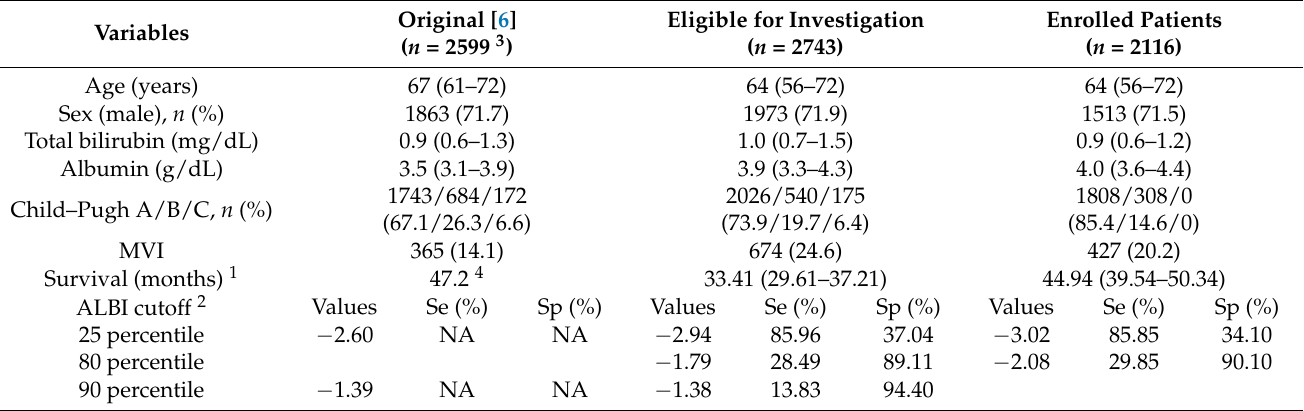
Table 2. Comparisons and different cutoffs for the ALBI grades in the original study and this